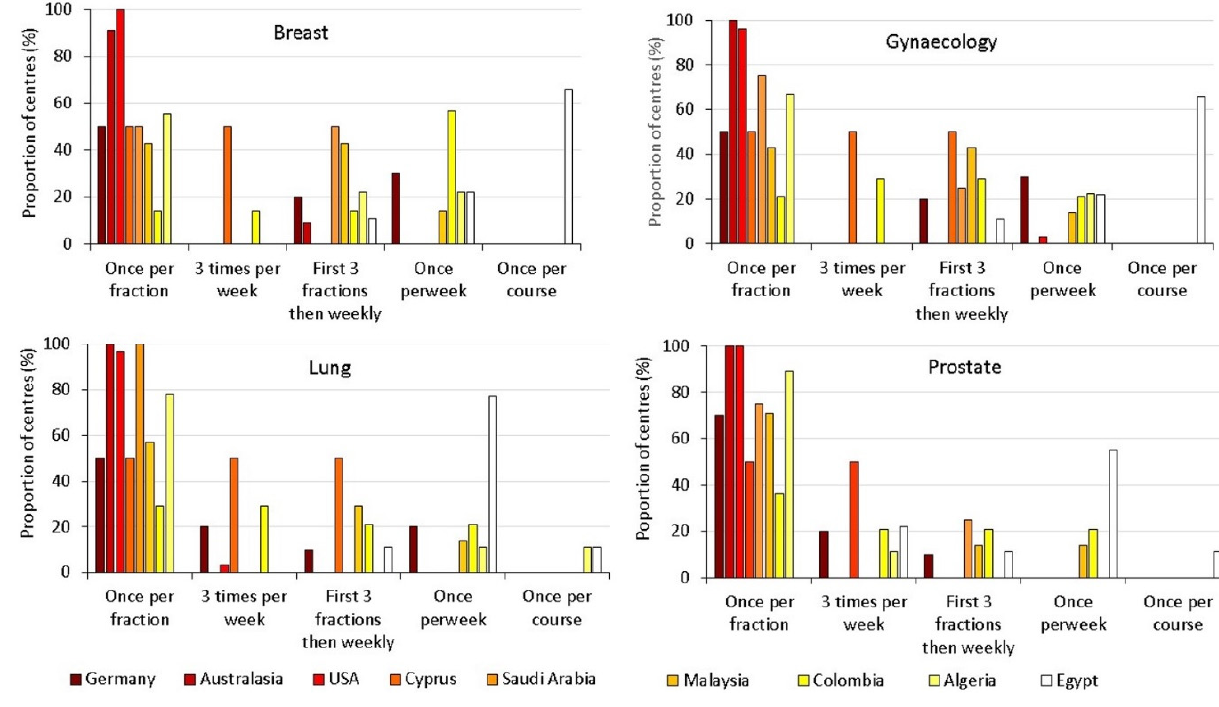
Figure 2. The frequencies of imaging used most commonly by each radiotherapy centre during treatment of tumours in the trunk, as a proportion of the centres surveyed in the country [14]. The countries are ordered using a temperature scale from dark red, through orange and yellow to white, indicating decreasing HDI.